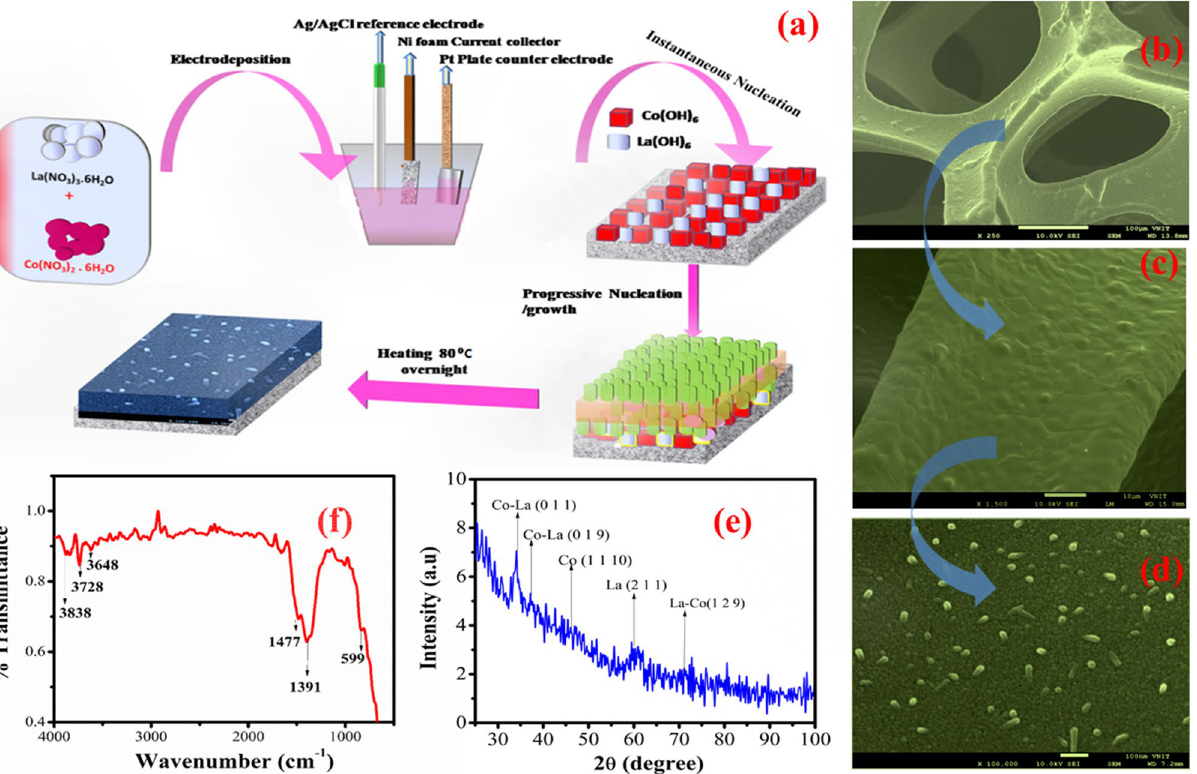
Figure 1. ( a ) Schematic diagram of formation of La–Co layered double hydroxides on Ni foam substrate, ( b–d ) shows the FESEM images of prepared La–Co LDH grown on Ni foam substrate, ( e ) X-ray diffraction spectra of La–Co LDH material, ( f ) FTIR spectroscopy of La–Co LDH material sheds the light on surface bonding and functionality present in the